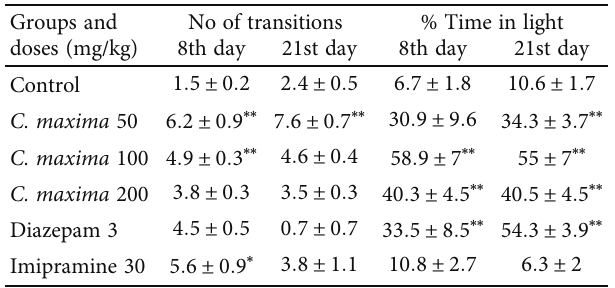
n = 10, average ± SEM; * P < 0 : 05 substantial; ** P < 0 : 01 greatly substantial in comparison with